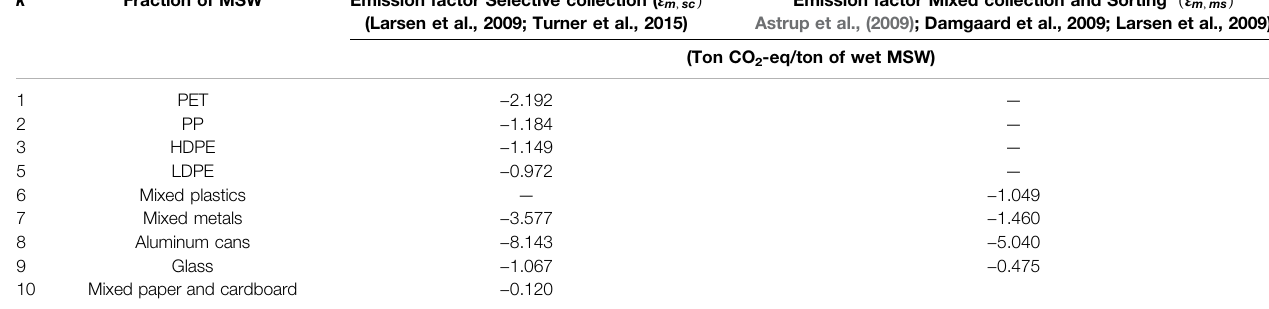
TABLE 1 | Emission factors for recoverable